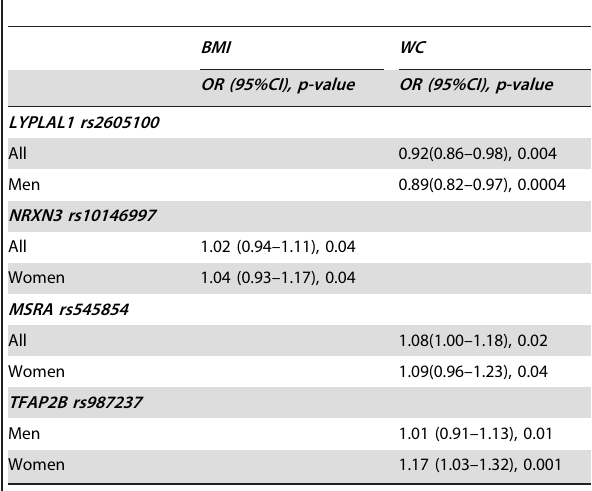
Table 2. Variants showing statistical significant associations with BMI and/or WC in the case-control analyses ( n